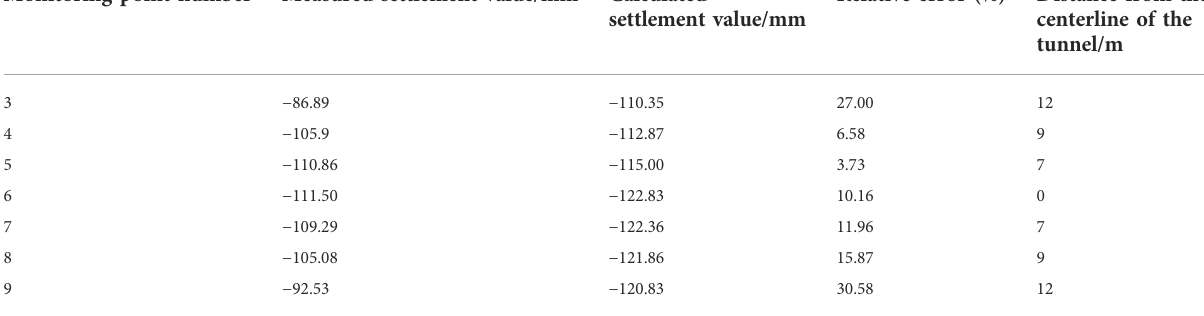
TABLE 3 Relative error between measured and calculated values of fi nal ground settlement. Monitoring point number Measured settlement value/mm Calculated Relative error (%) Distance from the settlement value/mm centerline of the tunnel/m − 86.89 − 110.35